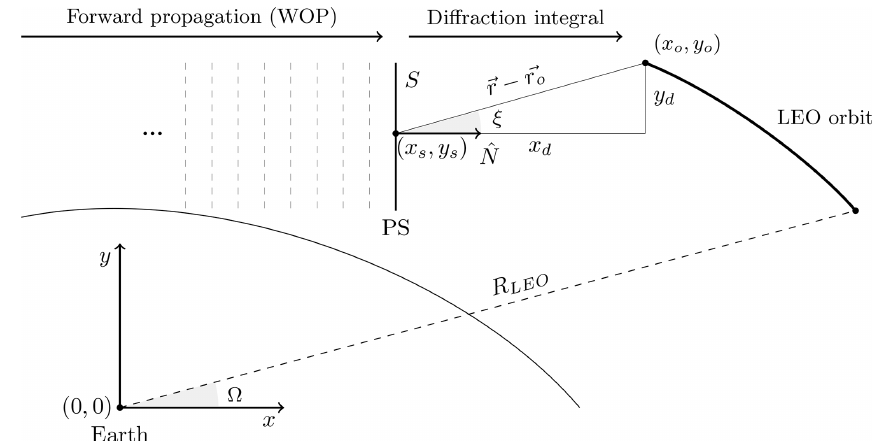
Figure 1. Diffraction propagation geometry. In simulations, the forward propagation is modelled with a wave optics propagator (WOP) to consider the ionospheric irregularities. From the rightmost phase screen (PS), the complex signal is integrated along S and projected to every point in the LEO orbit.